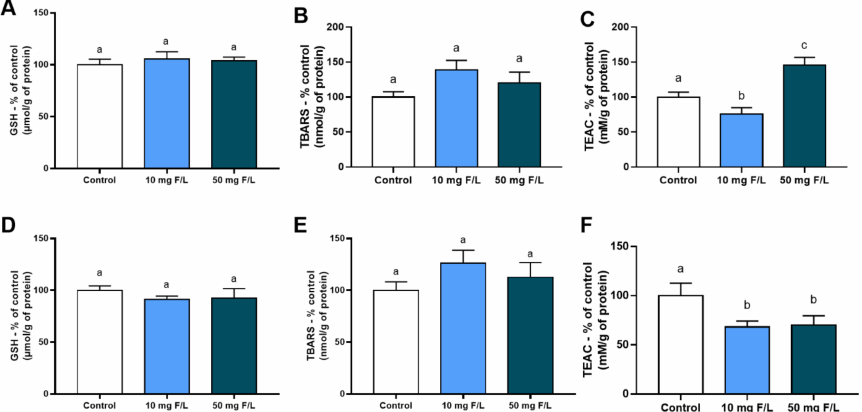
Figure 1. Oxidative biochemistry analyses in the parotid and submandibular glands of offspring exposed and not exposed to F, at doses of 0 mg F/L (control), 10 mg F/L, and 50 mg F/L for 42 days. In ( A ), reduced glutathione (GSH) levels in parotid glands; in ( B ) levels of thiobarbituric acid reactive substances (TBARS) in parotid glands; in ( C ), total antioxidant capacity (TEAC) of the parotid glands; in ( D ), GSH levels in submandibular glands; in ( E ) levels of TBARS in submandibular glands; in ( F ), TEAC of the submandibular glands. Quantitative results are expressed as mean ± standard error of mean, 1-way ANOVA test with Tukey’s post-test. Different letters mean statistical difference ( p < 0.05).